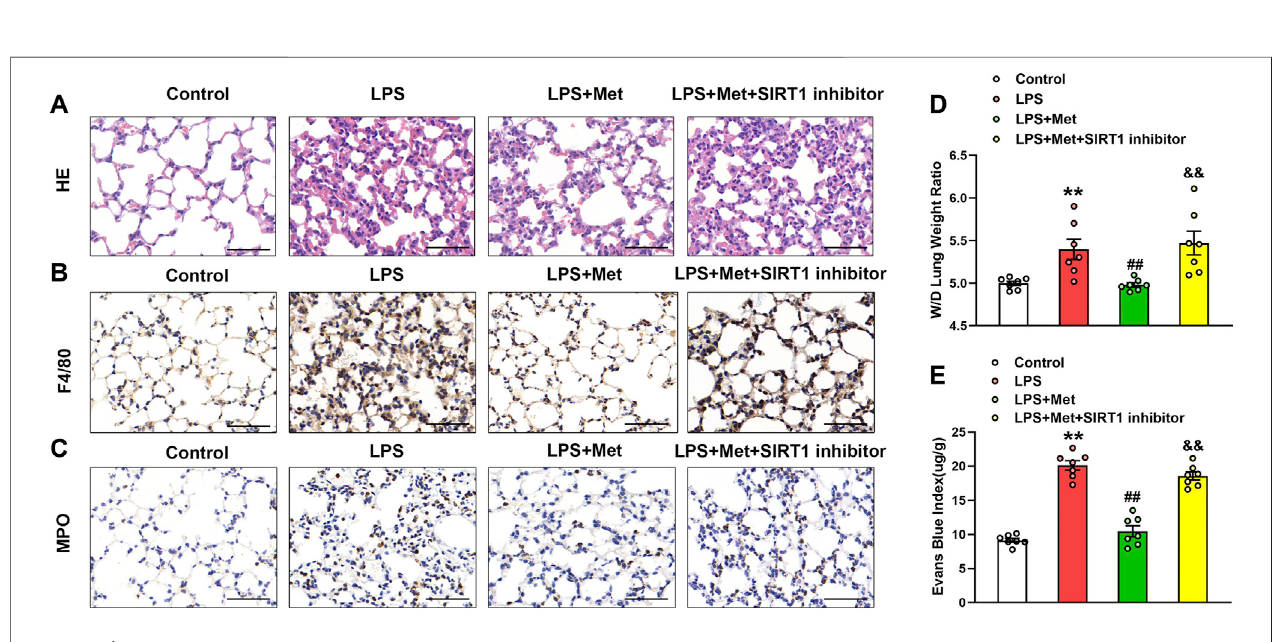
FIGURE 7 | The inhibition of SIRT1 prevents metformin from ameliorating the morphological characteristics and endothelial hyperpermeability of ALI. NAM (60 mg/kg) was administered 1 h before metformin administration. (A) Representative HE staining of lung tissues. (B) Immunohistochemistry analysis of F4/80. (C) ImmunohistochemistryofMPO. (DandE) LungW/D andEvans-bluedye extravasation weredetermined asindexesofpulmonary edema.Originalmagni fi cation, ×200. Scale bar, 50 μ m. Data are presented as the mean ± SEM ( n = 7). ** p < 0.01 vs. Control group, ## p < 0.01 vs. LPS group. && p < 0.01 vs. LPS + Met group.